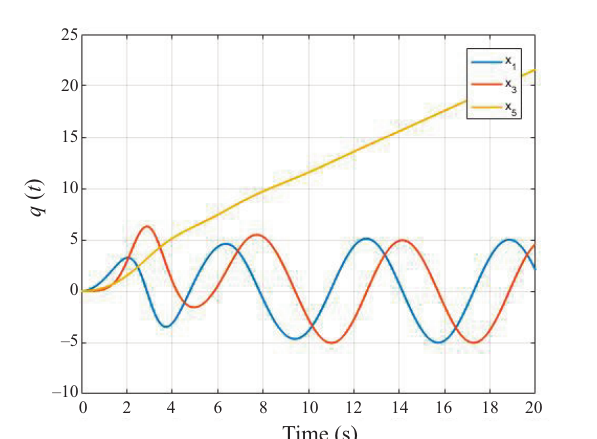
Figure 3. Control input ˆ u during stabilization maneuver. Fig. 3.